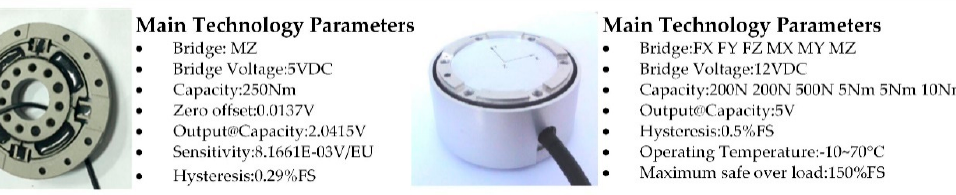
Figure 3. The detailed design of LLR-II leg mechanism.